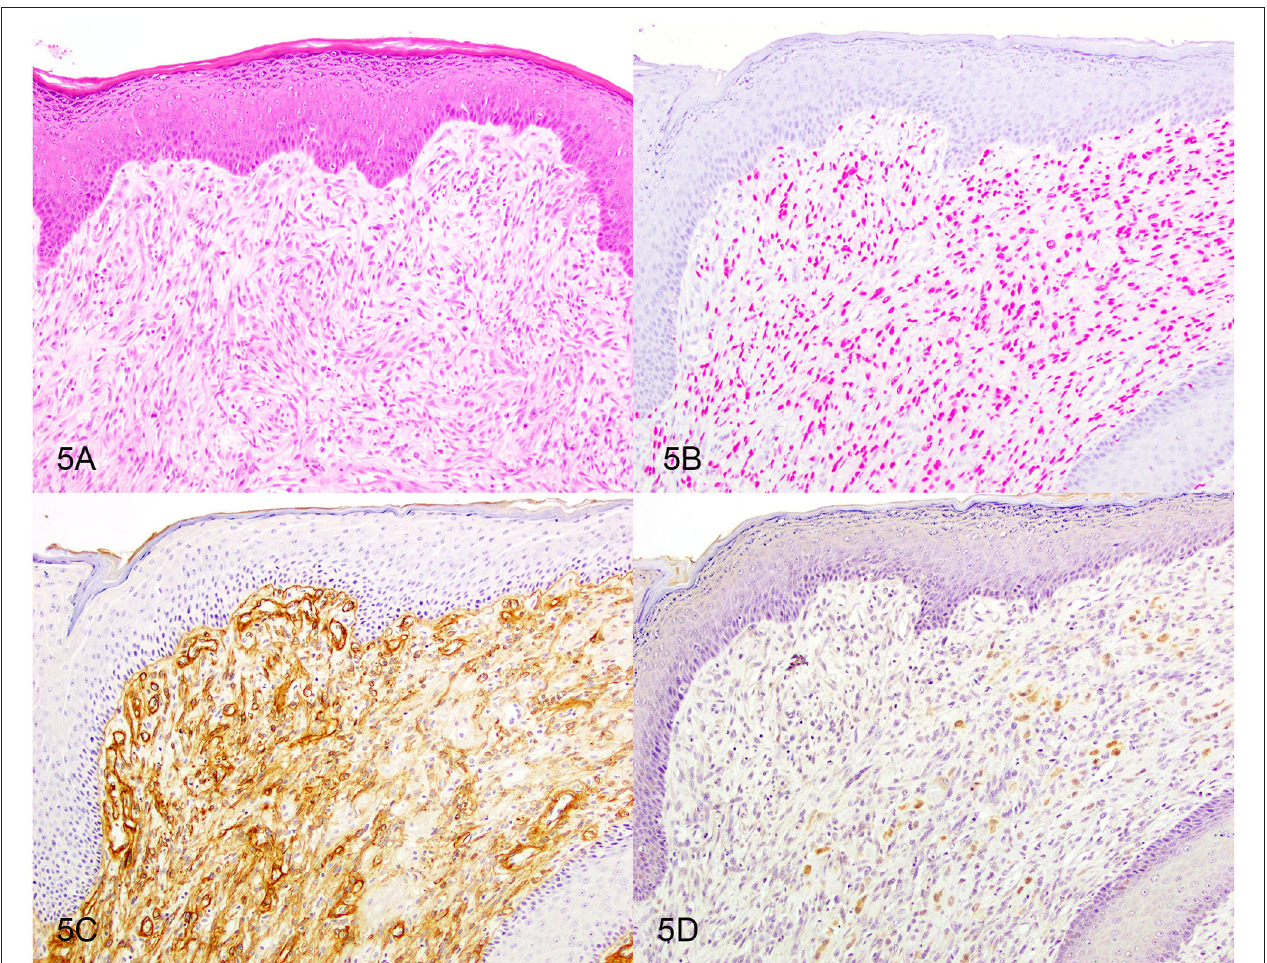
FIGURE 5 | Oral spindle cell tumor. Serial sections stained with (A) hematoxylin and eosin or immunohistochemically labeled for (B) SOX-10 showing red nuclear labeling or for (C) laminin showing brown basement membrane labeling or for (D) S100 showing brown cytoplasmic labeling. Magnification, × 20.